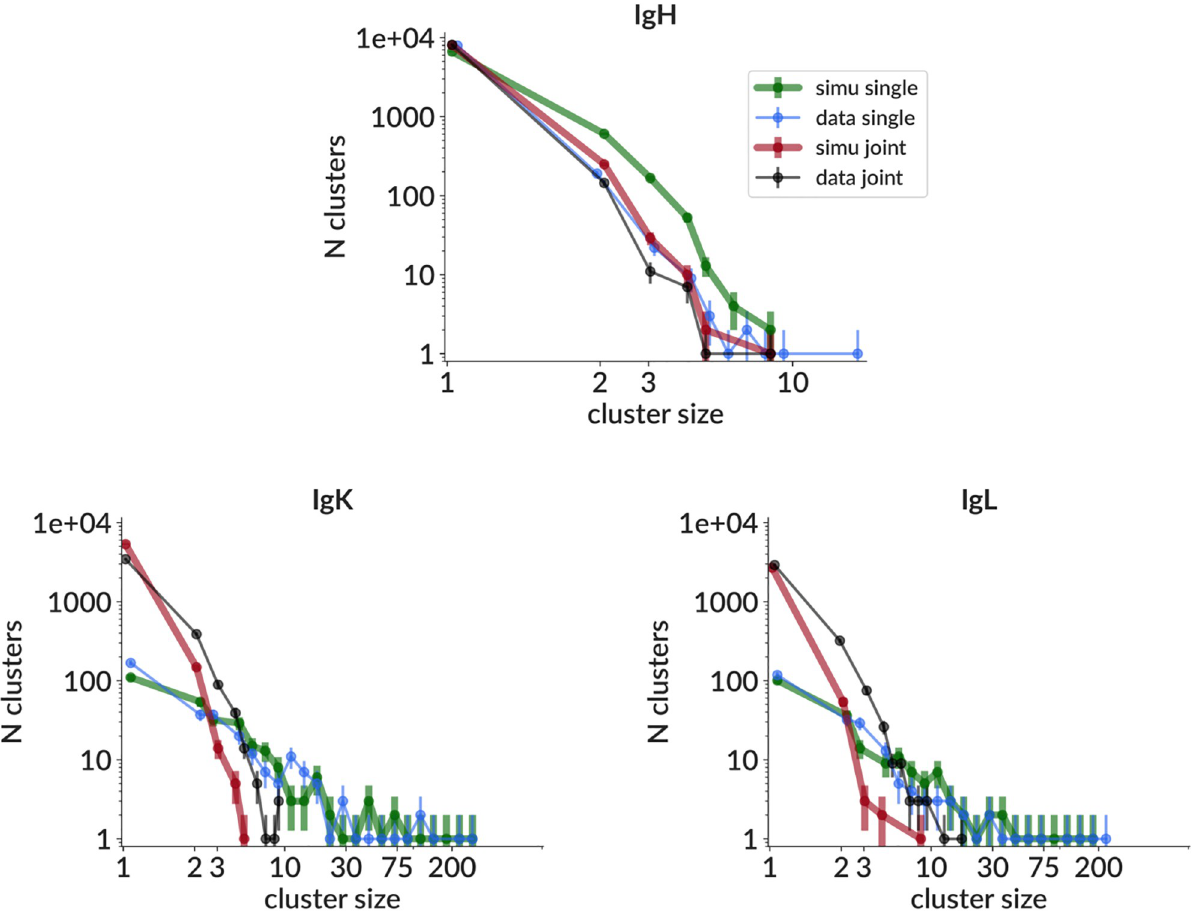
Fig 7. Cluster size distributions on real data (thin lines) and simulation (thick lines) for single chain (no paired clustering, blue/green) and joint (with paired clustering, black/red) partitions for IgH (top), IgK (bottom left) and IgL (bottom right). The real data sample is from the 10X website [45], while the simulation sample is generated to match that particular real data sample, i.e. from parameters inferred from that real data sample. Direct comparisons of other parameter distributions for these two samples are shown for a handful of parameters in S10 Fig. Comparisons for all parameters, along with similar analyses for three other real data samples from [45] may also be found at